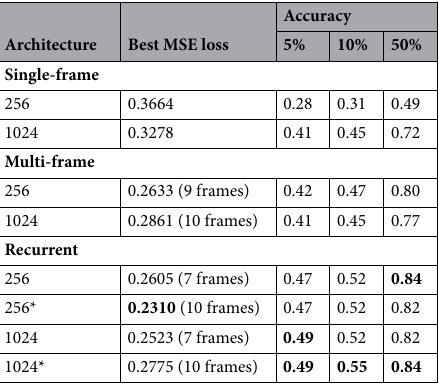
Table 2. Results for the architecture search. Mean squared error loss values for the normalized target (the same as in Fig. 5) and corresponding accuracies for 5%, 10%, and 50% deviations from the target value are provided. For multiframe and recurrent models, the number of input frames is shown. The best values are shown in bold. *Bidirectional; the best results are shown in